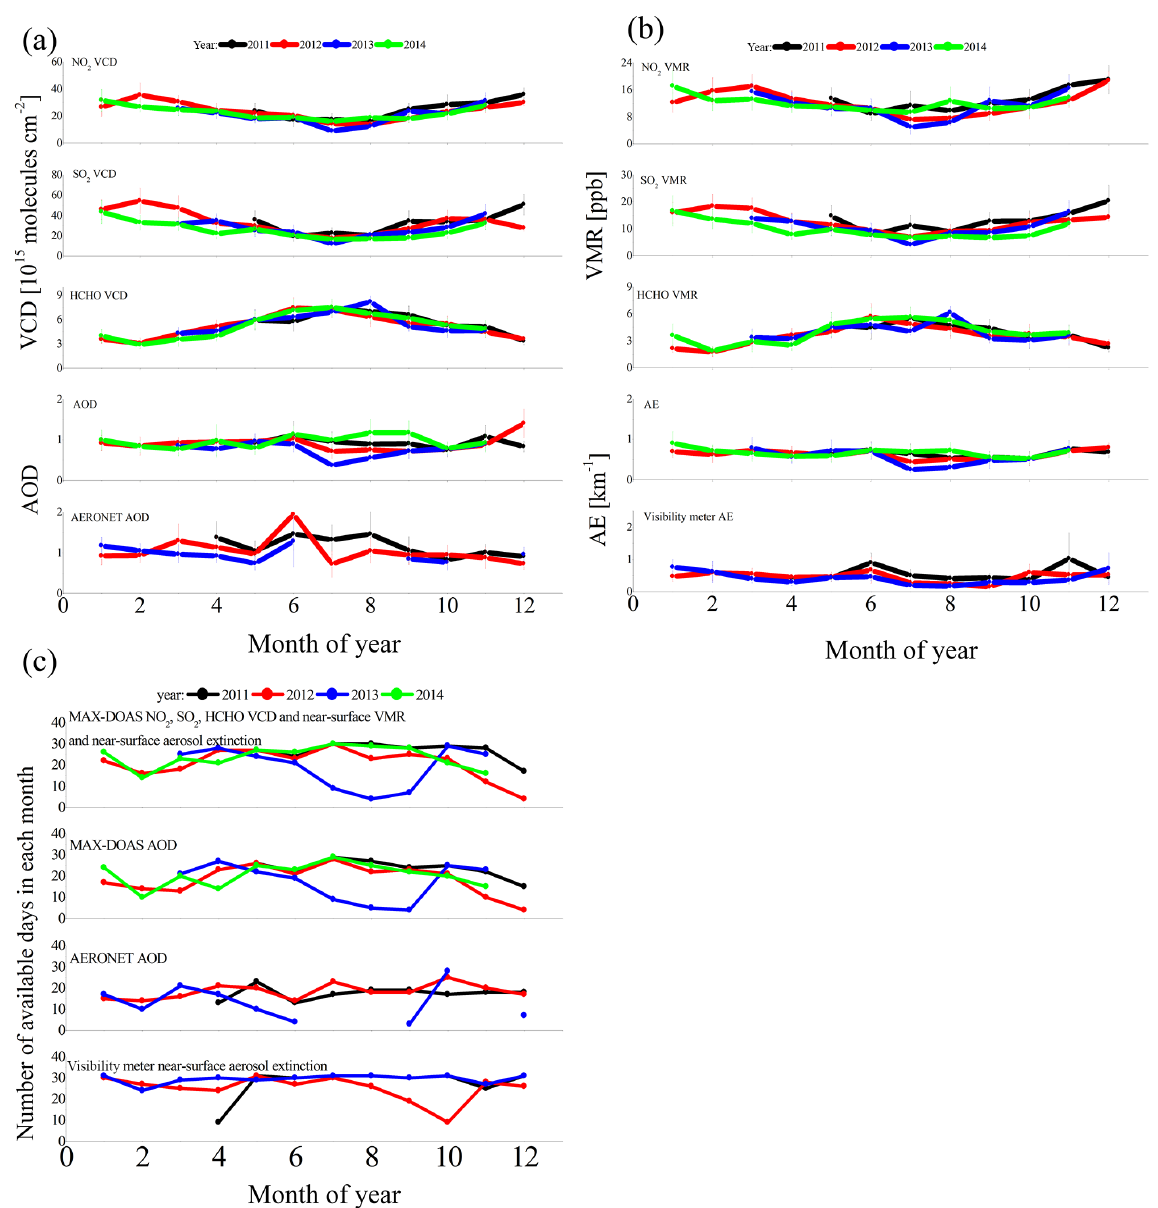
Figure 11. Seasonal cycle of monthly mean MAX-DOAS results: VCD and AOD (a) and near-surface VMR of NO 2 , SO 2 and HCHO and AE (b) for May 2011 to November 2014. The error bars represent the standard deviations. In addition to the MAX-DOAS data, AOD and AE from AERONET and the visibility meter are also shown, respectively. The numbers of available days in each month for MAX-DOAS measurements, AERONET and the visibility meter are shown in (c) . The different numbers of available AOD and trace gas data derived from MAX-DOAS are caused by the filtering scheme (see Table